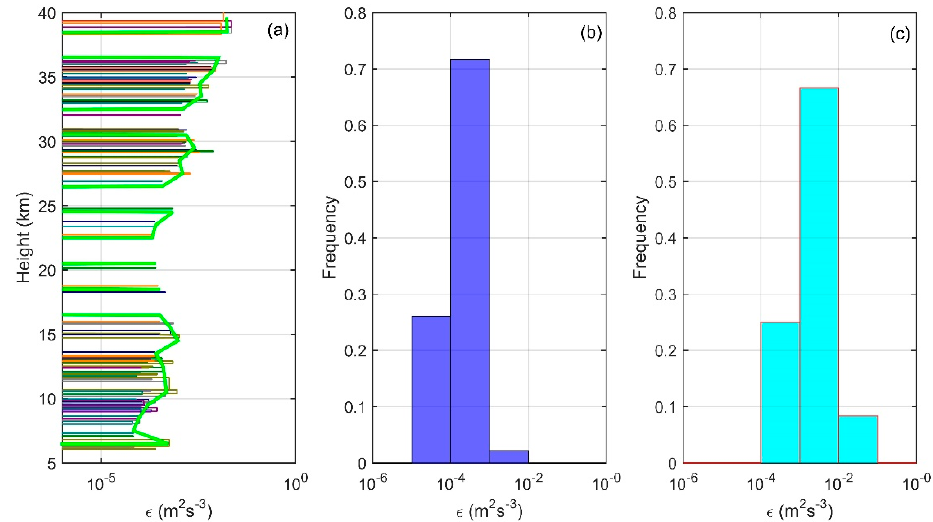
ε ( a ) and frequency distribution of